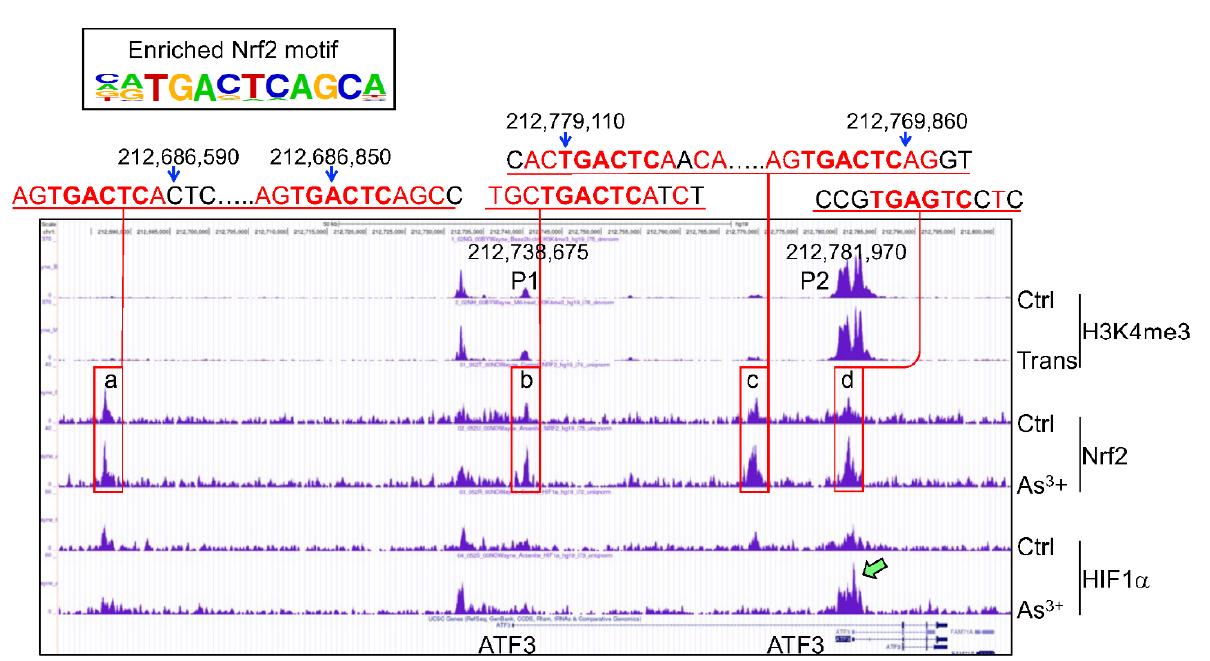
Figure 4. Nrf2-dependent expression of ATF3. Panel shows screenshot of H3K4me3 ChIP-seq of the control cells and transformed cells (Trans), and Nrf2 and HIF1α ChIP-seq of the control cells and the cells treated with 1 μM arsenic (As 3+ ) for 6 h, for the ATF3 gene. P1 and P2 represent the distal and proximal ATF3 promoters, respectively. Red boxes indicate the major Nrf2 peaks in the ATF3 gene. The conserved Nrf2 elements are shown on the top of each box. Numbers on the top of Nrf2 elements indicate the relative positions of these elements in human genome (hg19). Top left box shows the enriched Nrf2 binding motif as determined by the HOMER program in ChIP-seq.